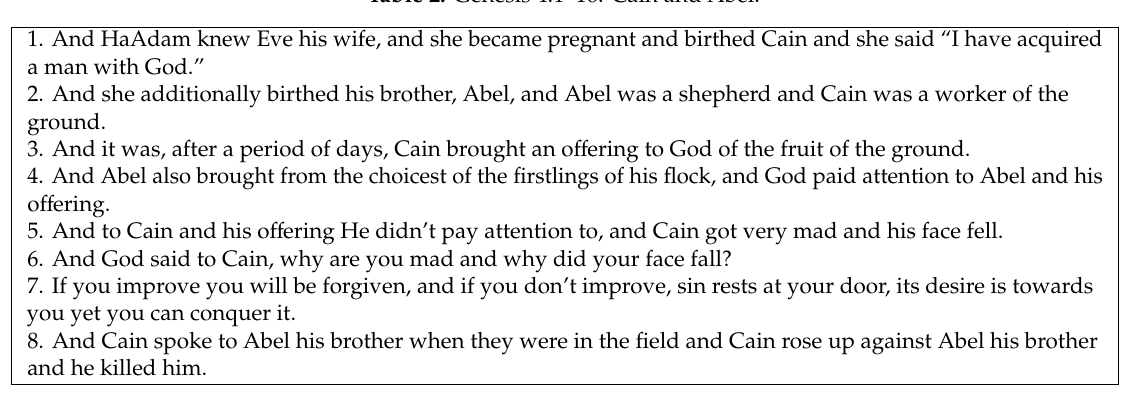
Table 2. Genesis 4:1–16: Cain and